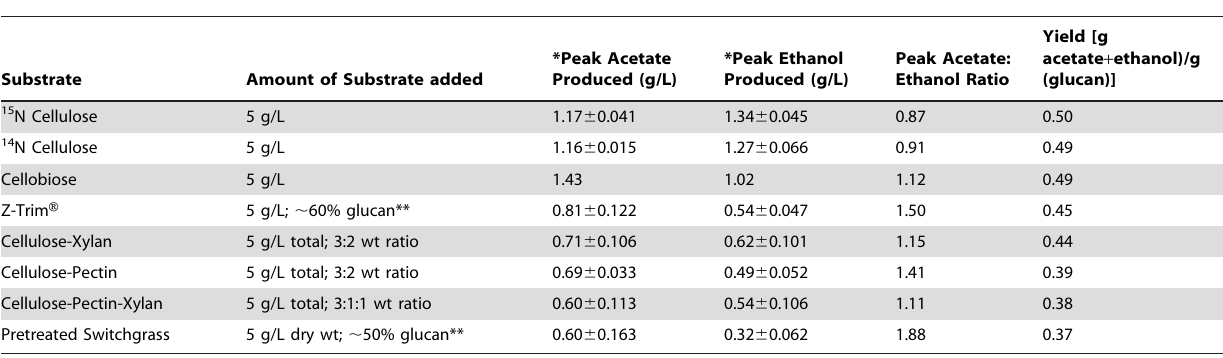
Table 1. Acetate and ethanol production during growth on pretreated switchgrass and other biomass carbohydrates.